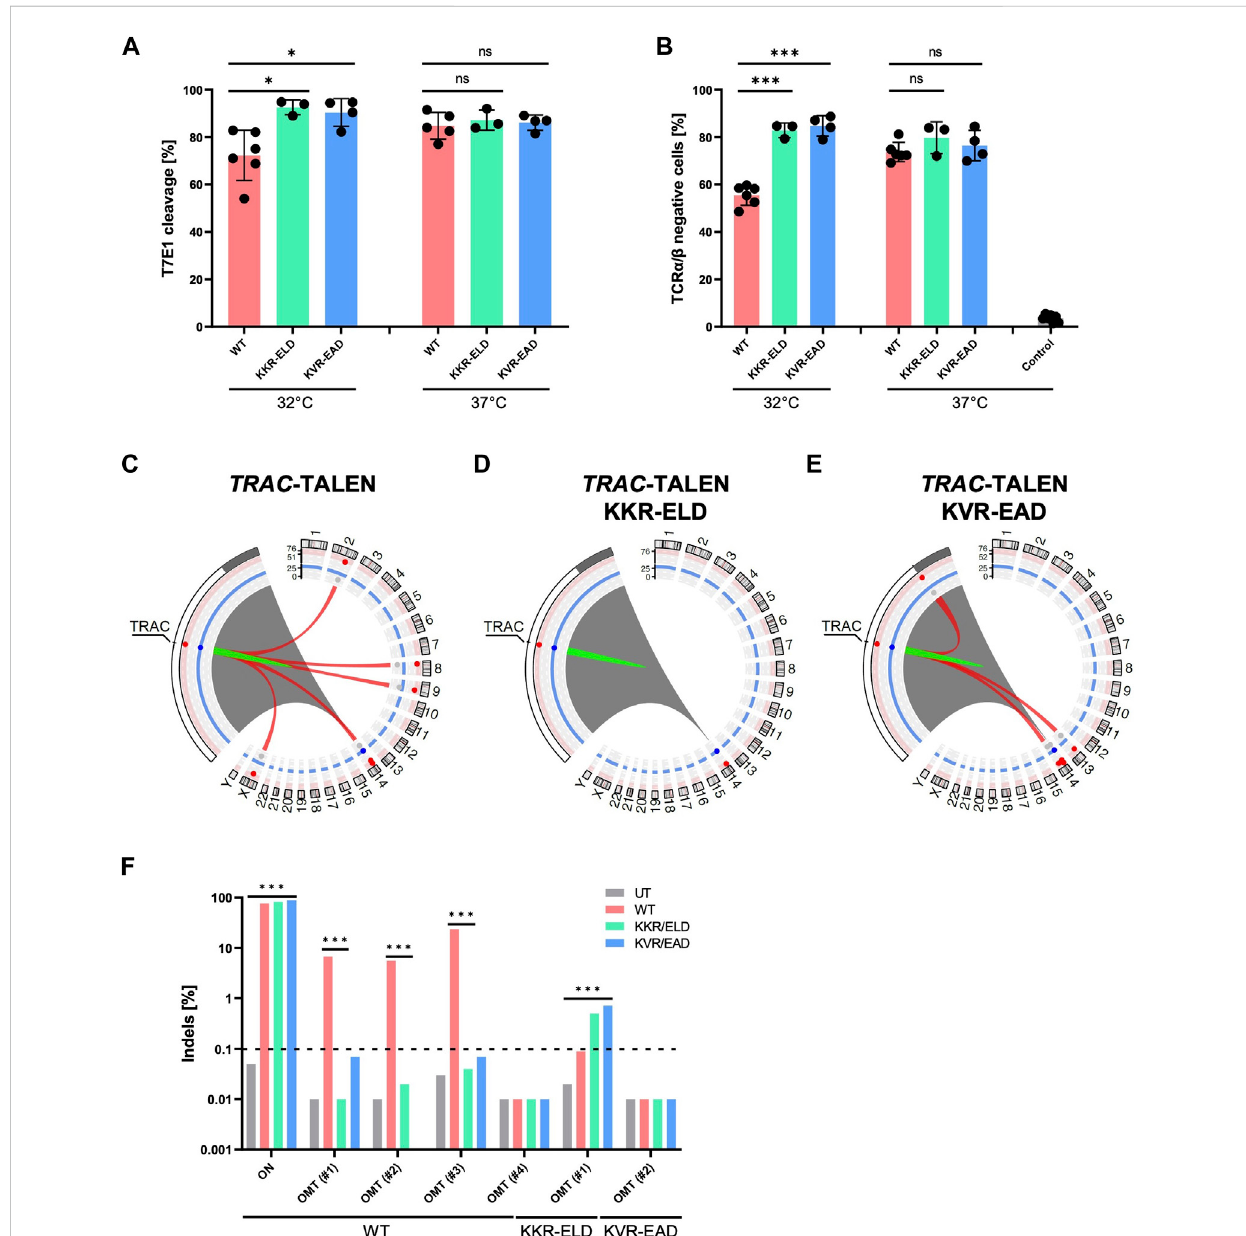
FIGURE 4 T-CAST analysis for TRAC -targeting TALENs (A) Genotyping. Results of T7E1 assay of WT-TALEN and OH-TALEN (KKR-ELD and KVR-EAD con fi guration) are shown. 32 ° C indicates that T cells were subjected to transient cold-shock after electroporation, while control cells were constantly culturedat37 ° C.*speci fi es p -value < 0.05(Student ’ st-test,n=3 – 6). (B) TCRexpression.DisplayedisthefractionofTCR α / β -negativeTcellsupontransfer of TALEN-encoding mRNA as determined by fl ow cytometry. Where indicated (32 ° C) T cells were subjected to a transient cold-shock. *** speci fi es p -value < 0.001 (Student ’ s t-test; n = 3 – 7). (C – E) Structural variations. Circos plots illustrate T-CAST results with enlargement of the chromosome 14regionencompassing TRAC .Redlinesrepresentchromosomal rearrangements(OMTswith > 20hits)withthe TRAC targetsite. (F) Genotyping.NGSat denoted sites was performed on untreated (UT) T cells, and T cells edited with WT-TALENs or OH-TALENs as indicated. The group in which the samples were originally identi fi ed is indicated on the bottom. *** speci fi es p -value < 0.001 (Fisher ’ s exact test, Bonferroni corrected p